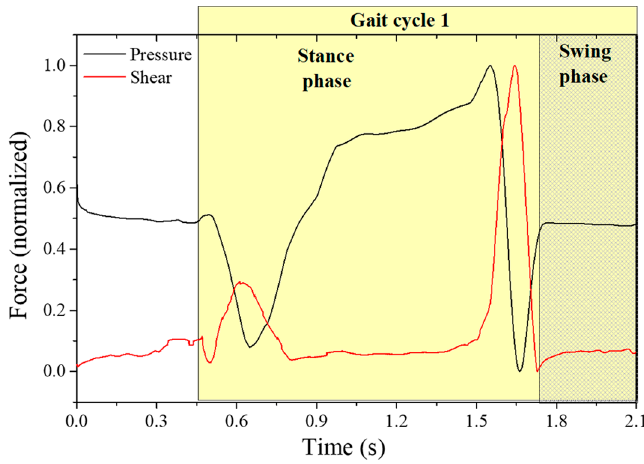
Figure 11. Plantar pressure and shear stress retrieved from the sensing cells in the insole during gait.